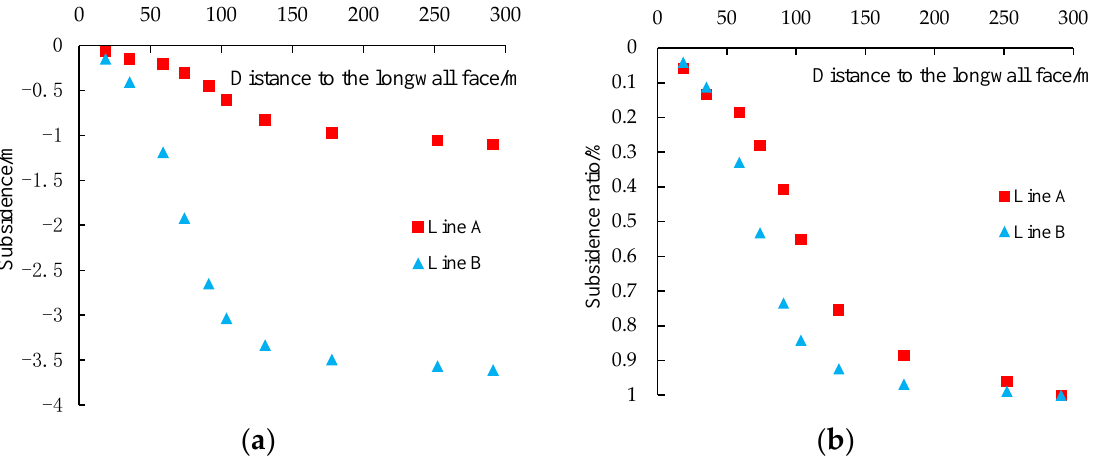
Figure 3. Comparison of the subsidence between lines A and B with the advancement of the working face. ( a ) subsidence trend of lines A and B; ( b ) subsidence ratio of lines A and B.